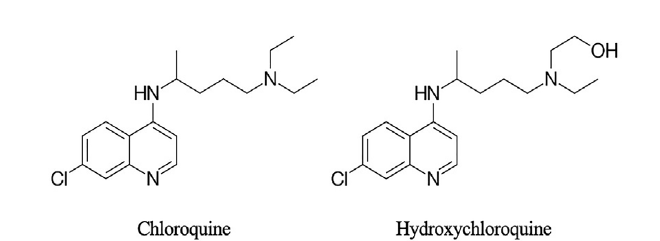
Figure 1. Structural comparison of chloroquine and hydroxychloroquine.